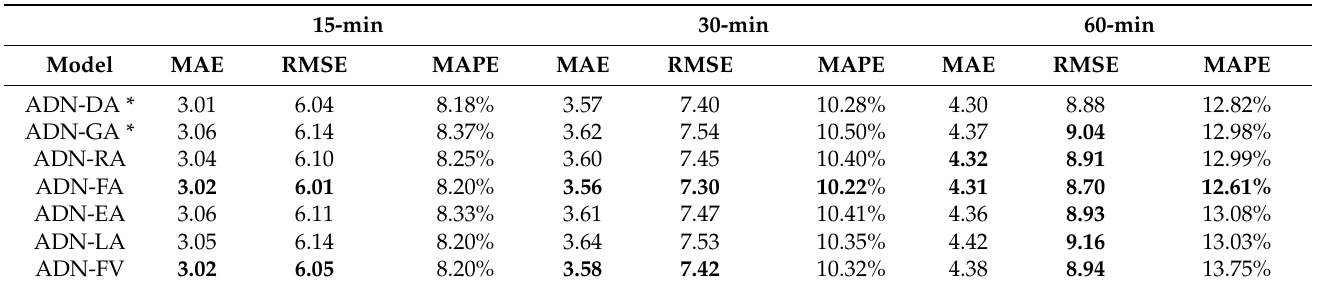
Table 4. Errors of models based on ADN with different attention mechanisms, on Metr-LA. Models marked with * represent our own implementation of the baseline.